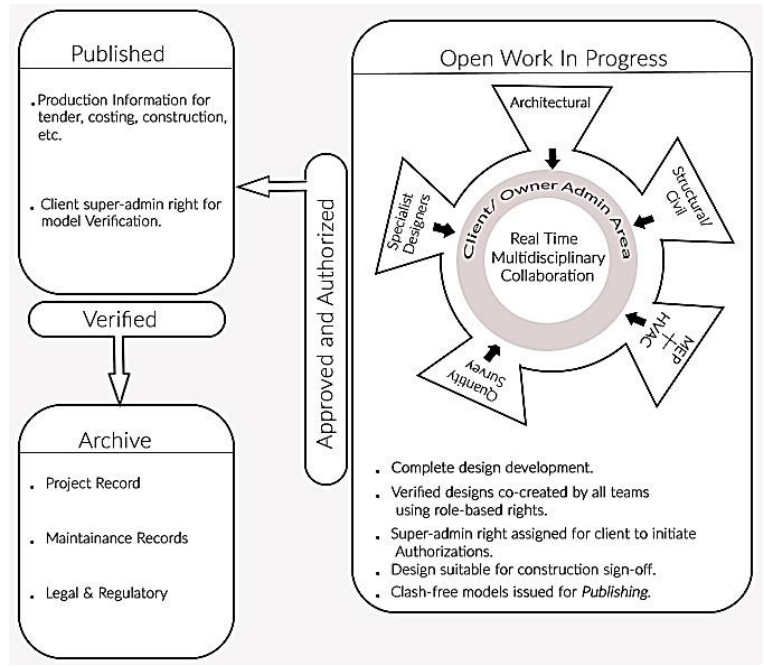
Figure 6. Proposed common data environment (CDE) with an open work in progress (OWIP).